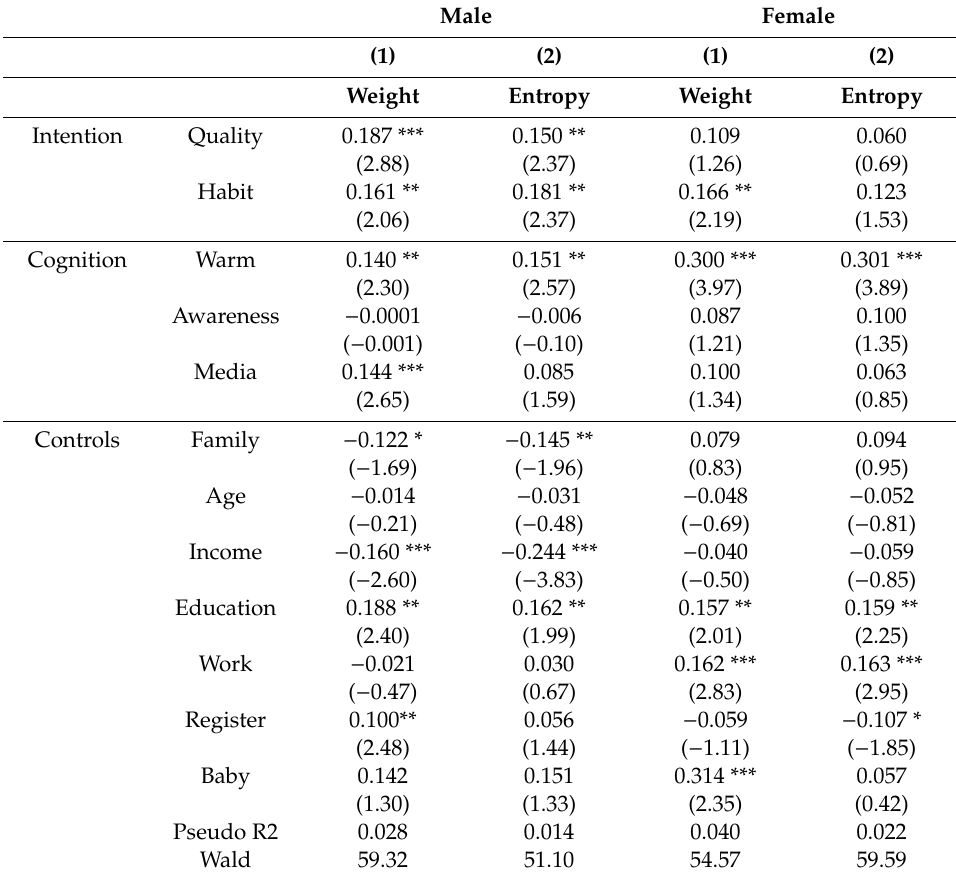
Table 6. Regression analysis on low-carbon behaviors based on